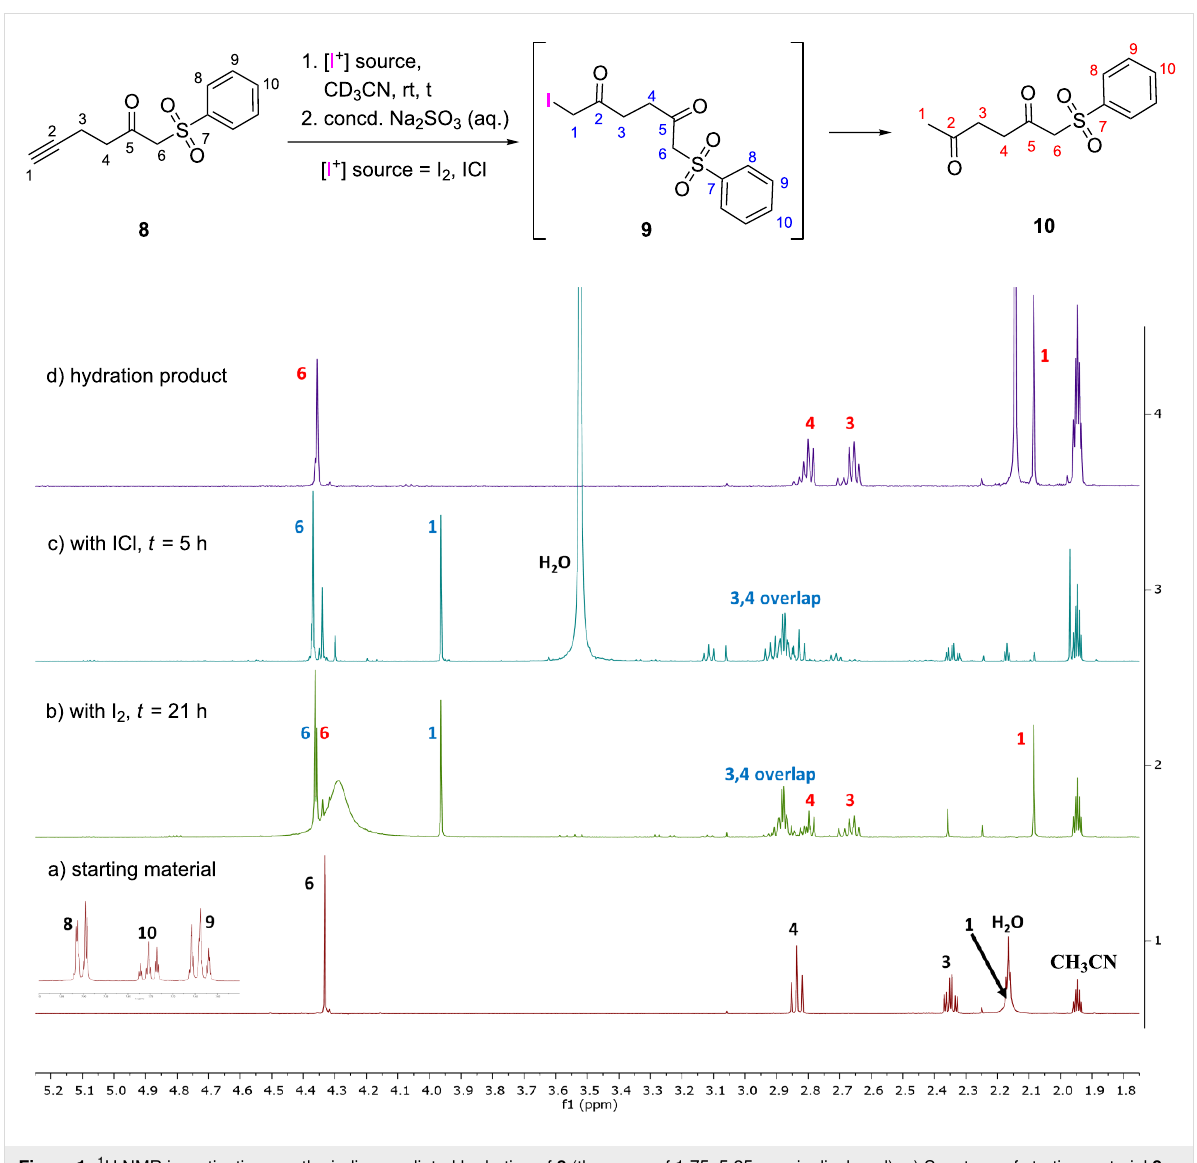
Figure 1: 1 H NMR investigations on the iodine-mediated hydration of 8 (the range of 1.75–5.25 ppm is displayed). a) Spectrum of starting material 8 . b) Spectrum of 8 upon treatment with two equivalents of I 2 . c) Spectrum of 8 upon treatment with two equivalents of ICl. d) Spectrum of the hydration product 10 . Figure 1a inset shows the phenyl region in the range of 7.55–8.00